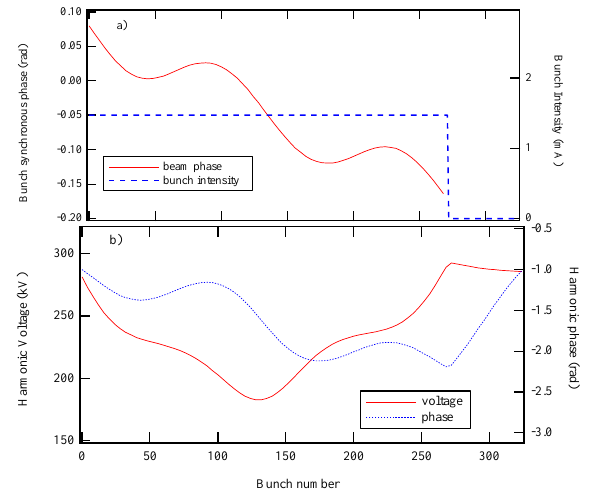
FIG. 9. (Color) Influence of two parked cavities on the har- monic voltage (full line) and phase (dotted line) with three har- monic cavities tuned to h res (cid:1) 984.32 and two harmonic cavities parked at h res (cid:1) 986.5 and 981.5, I beam (cid:1) 400 mA.